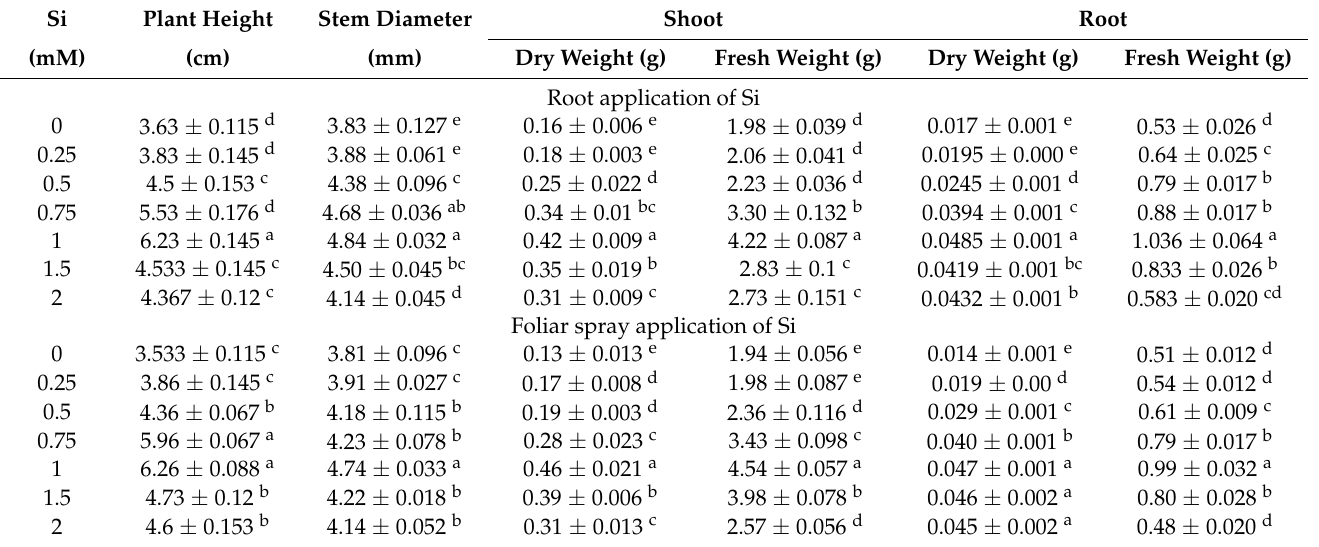
Table 3. Si concentration